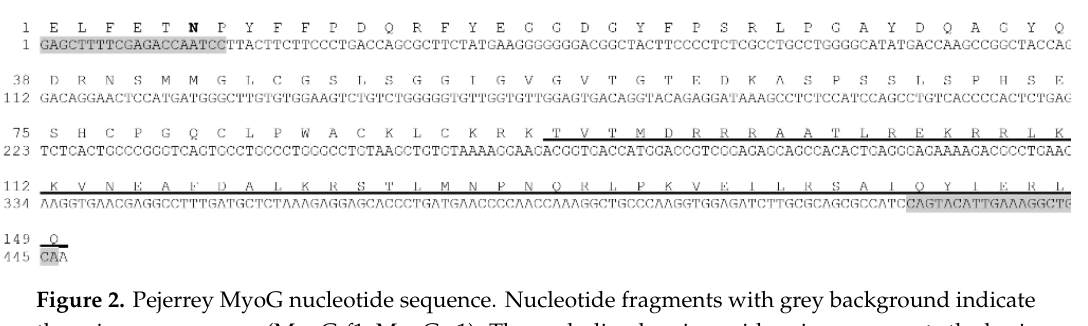
Figure 1. Pejerrey myostatin (MSTN) nucleotide sequence. Nucleotide fragments with grey background indicate the primers sequences (MSTN-f1, MSTN-r1). Proteolytic processing site RXXR was highlighted. Nine conserved cysteines in the bioactive TGF-β2 domain (underlined) were marked in white with a black background. A potential N-linked glycosylation site is marked in bold.